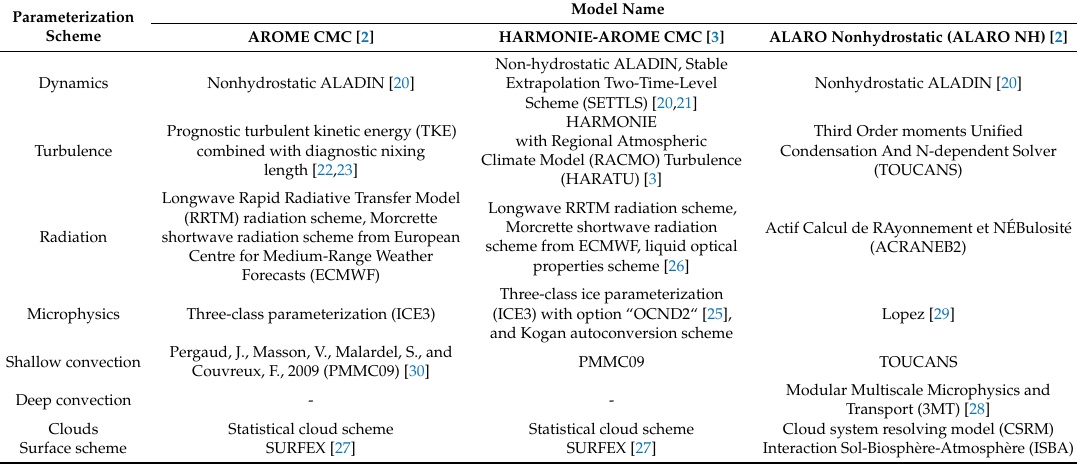
Table 3. Physics schemes used in tests of ALADIN HIRLAM